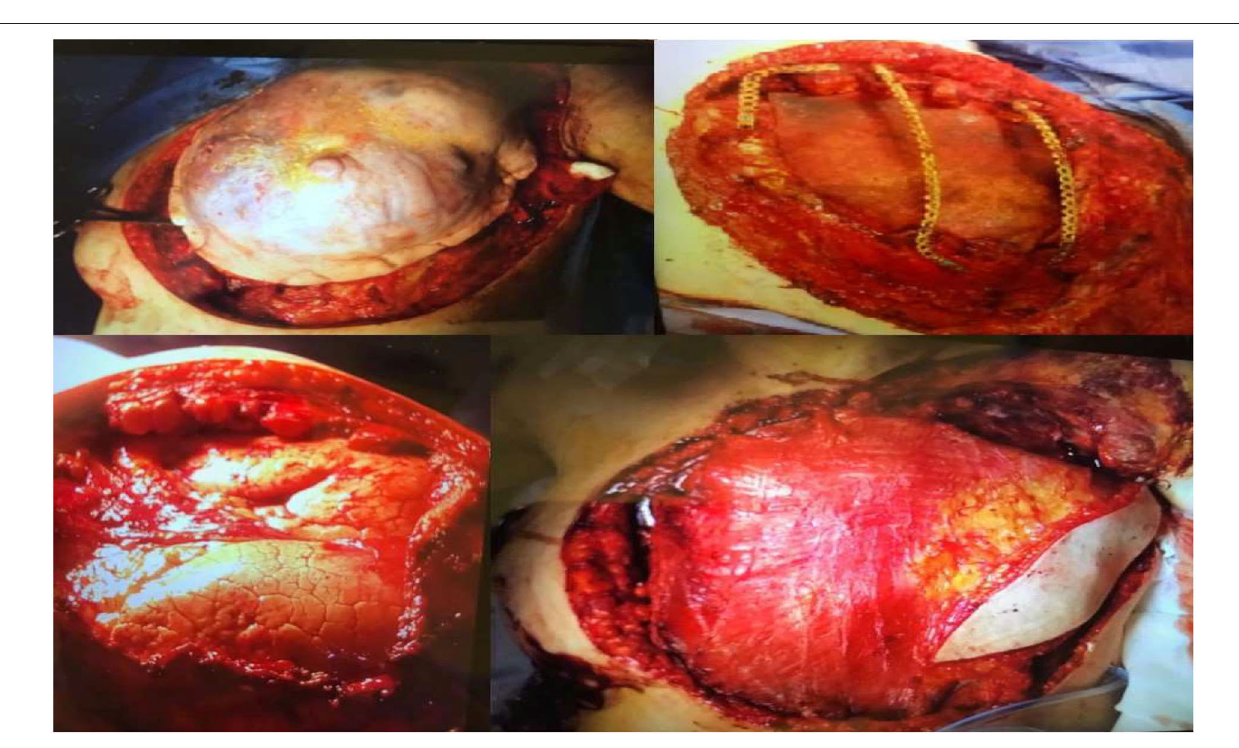
FIGURE 3 | Intraoperative